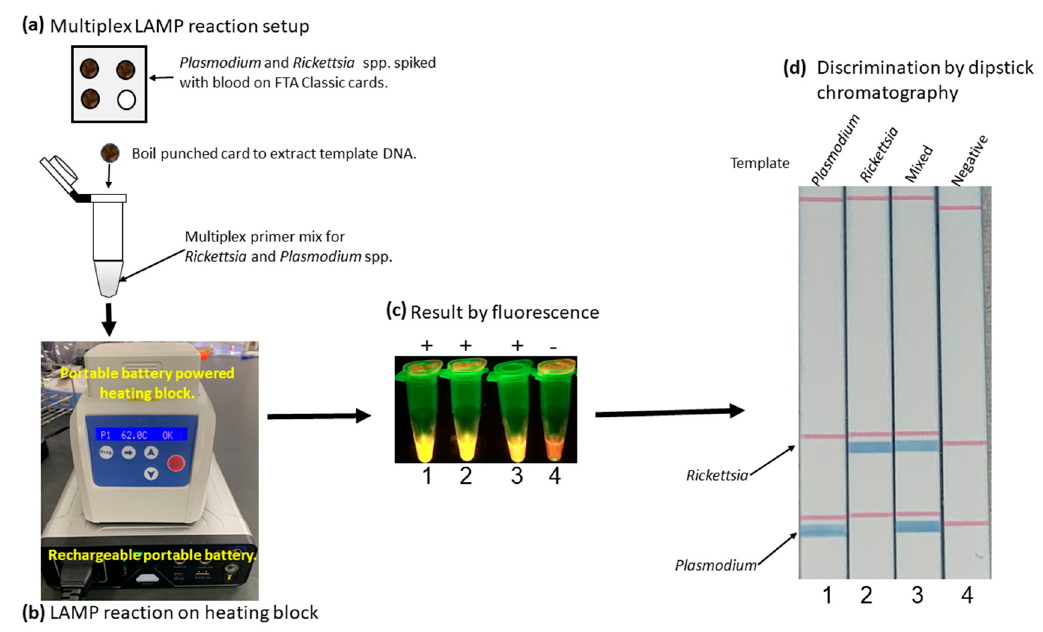
Figure 5. Simplified multiplex LAMP detection of R. monacensis and P. falciparum spiked with human blood. ( a ) shows the multiplex LAMP reaction setup using R. monacensis and P. falciparum spiked with blood, dried on Whatman FTA Classic card, and genomic DNA extracted by boiling. ( b ) shows the performance of LAMP using a rechargeable battery-powered heating block. ( c ) shows the detection result by fluorescence, while ( d ) shows multiple amplicon discrimination by dipstick chromatography.